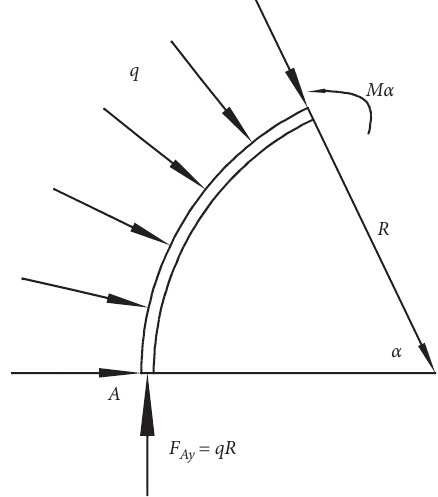
Figure 6: Bending moment of a semicircular arch.